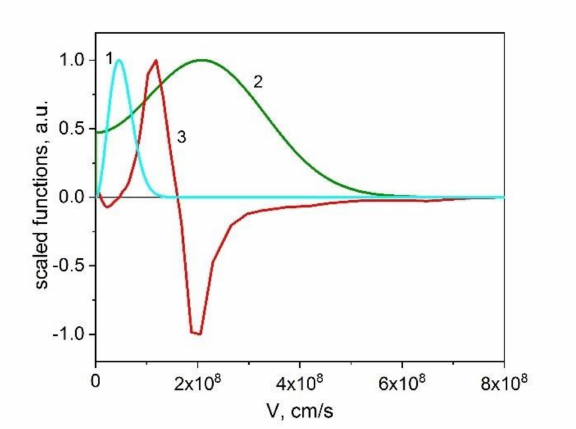
Figure 3. EVDF 1 after the maxwellization process (1), EVDF 2 after the isotropisation process (2) and ν ∂ν tr ( ν ) ∂ν (3). Characteristic times of maxwellization and isotropization processes are and τ is 2 ≈ 0.15 × 10 − 12 s correspondingly (see the estimates above). All the functions are scaled (divided by maximum values). EEDF 1 and EEDF 2 represent the velocity distribution in three-dimensional velocity space and normalized by the condition